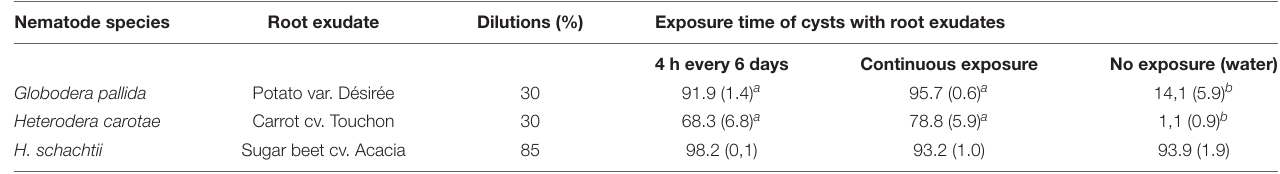
4 h every 6 days Continuous exposure No exposure (water)